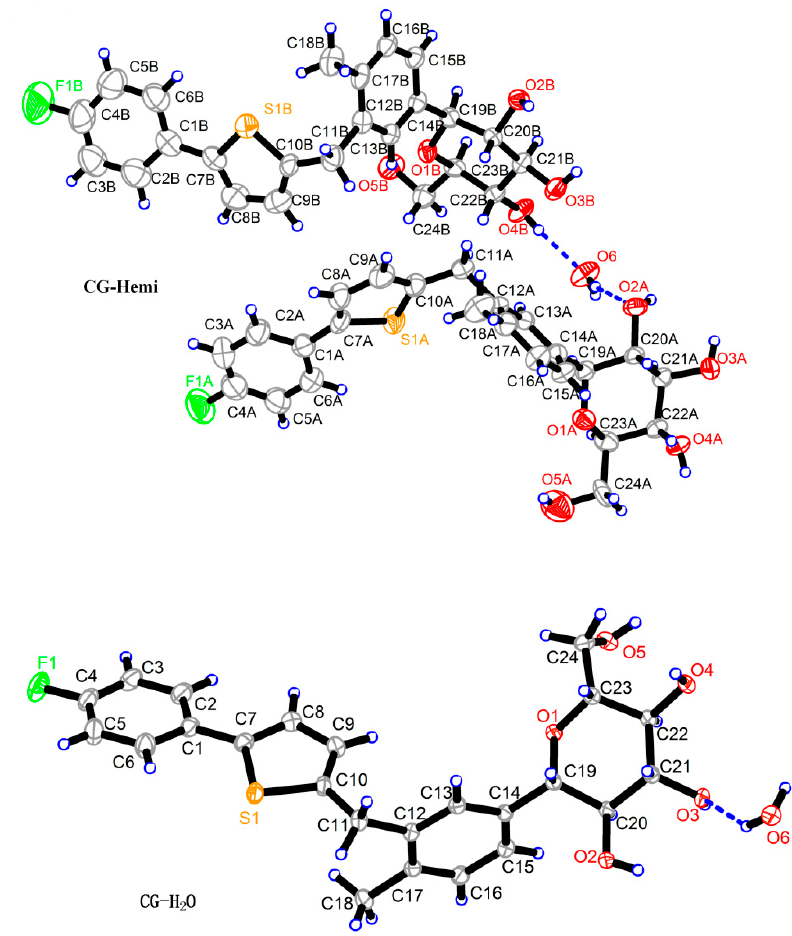
Figure 1. ORTEP (Oak Ridge Thermal Ellipsoid Plot Program) diagrams of CG-Hemi and CG-H 2 O. There are two CG molecules and one water molecule in CG-Hemi. There are one CG molecule and one water molecule in CG-H 2 O.